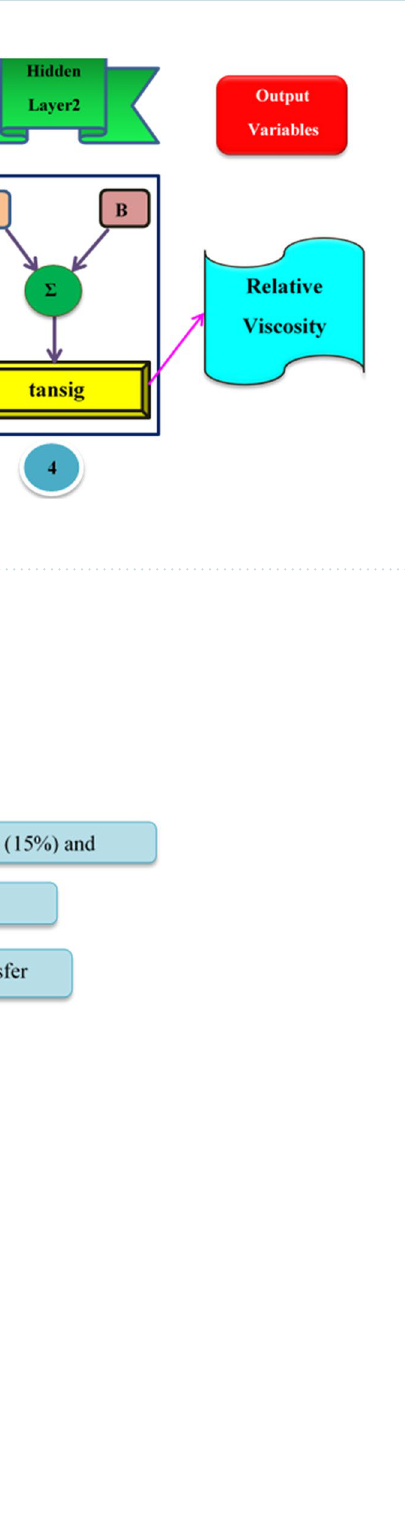
Figure 2. Flowchart of the suggested algorithm to achieve the optimal